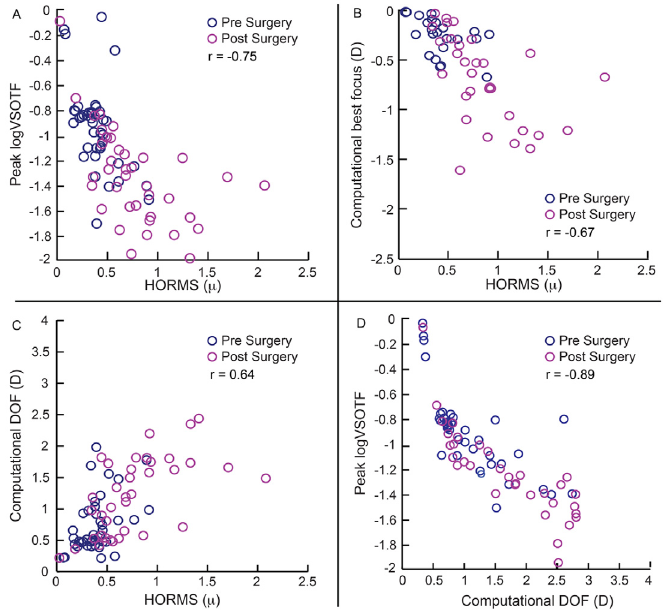
Fig 4. Relation between peak logVSOTF, computational best focus, computational DOF and HORMS obtained from the second arm of study. All other details are similar to Fig 3.